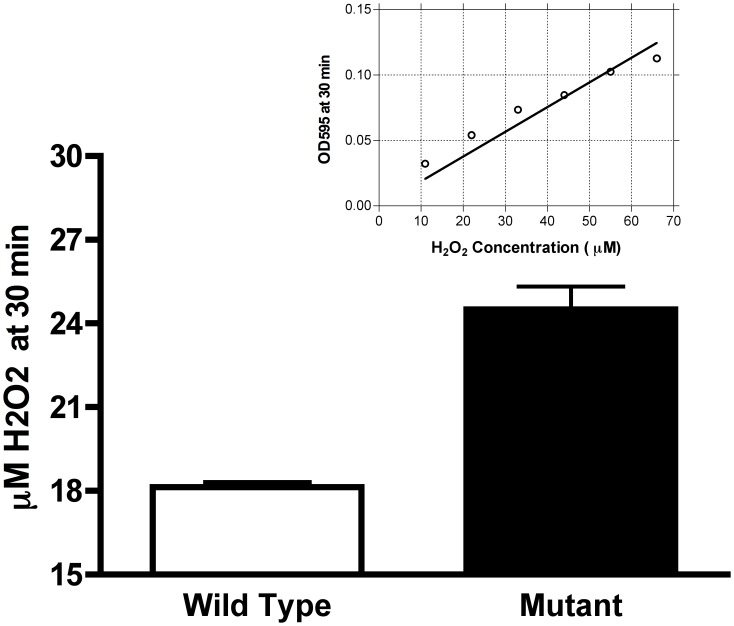
H202 production in the Mycoplasma mycoides capri GM12 wild type and the ctpA(clpP)::tetM mutant.Production of H202 by 108 cells/ml of either the wild type or mutant was determined after a 30 min incubation with 100 µM glycerol. Production of H202 was significantly increased (P<0.01, unpaired T test) in the mutant. The standard reference curve is shown in the inset.